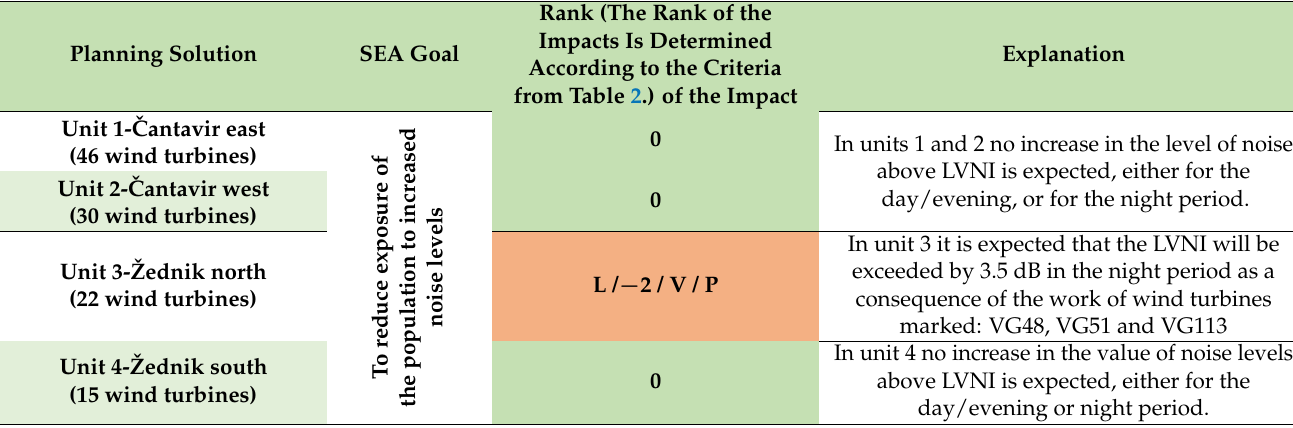
Planning Solution